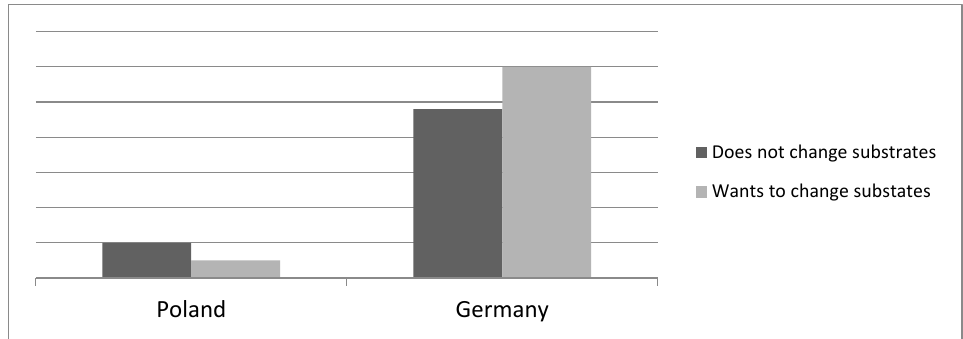
Figure 5 . Willingness of biogas plant users to change substrates based on own research. Figure 5. Willingness of biogas plant users to change substrates based on own